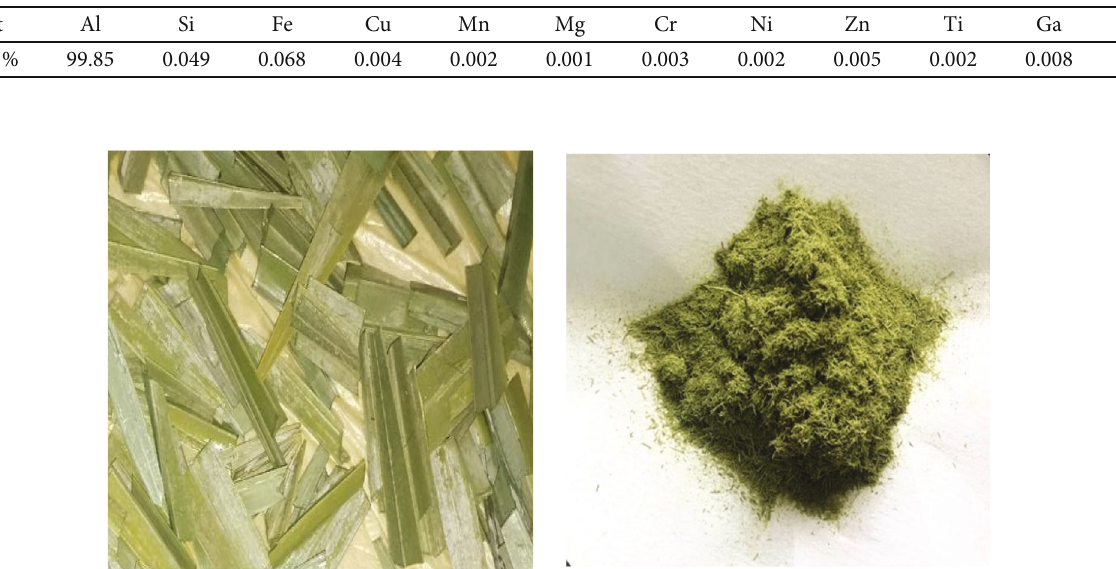
Figure 1: Phoenix dactylifera leaves and